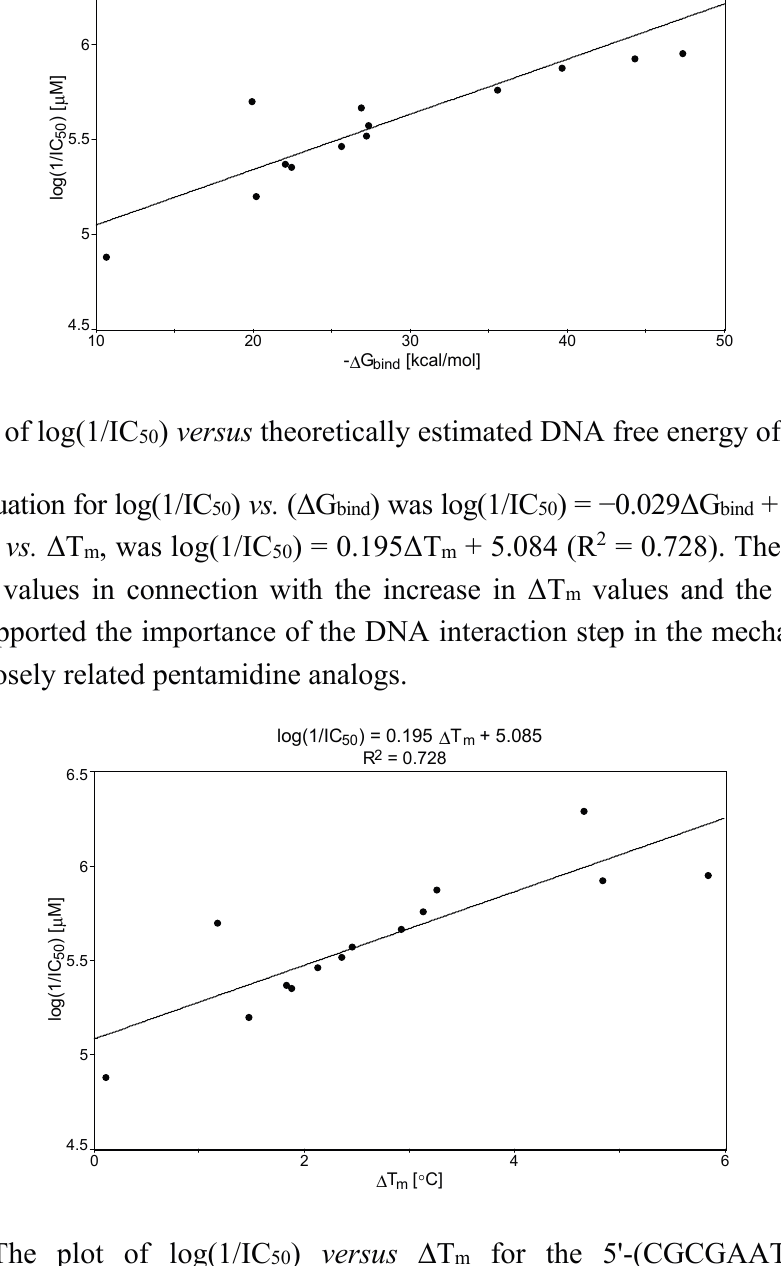
Figure 3. The plot of log(1/IC 50 ) versus Δ T m for the 5'-(CGCGAATTCGCG) 2 -3' dodecamer-bisamidine